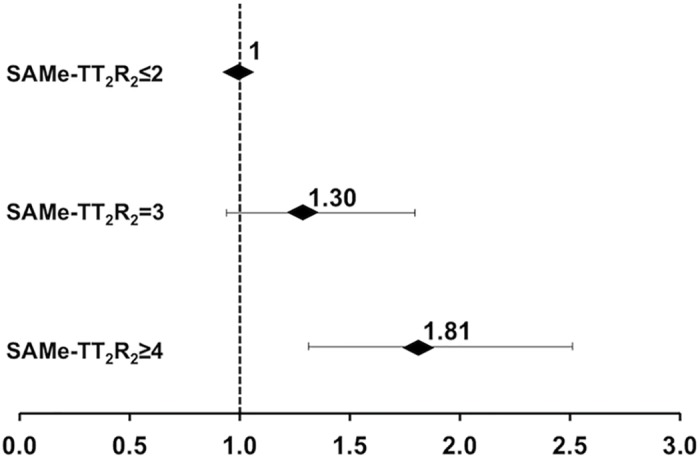
Hazard Ratios of different strata of SAMe-TT2R2 scores on ischemic stroke.Horizontal lines represent 95% confident intervals (CIs) around point estimates.